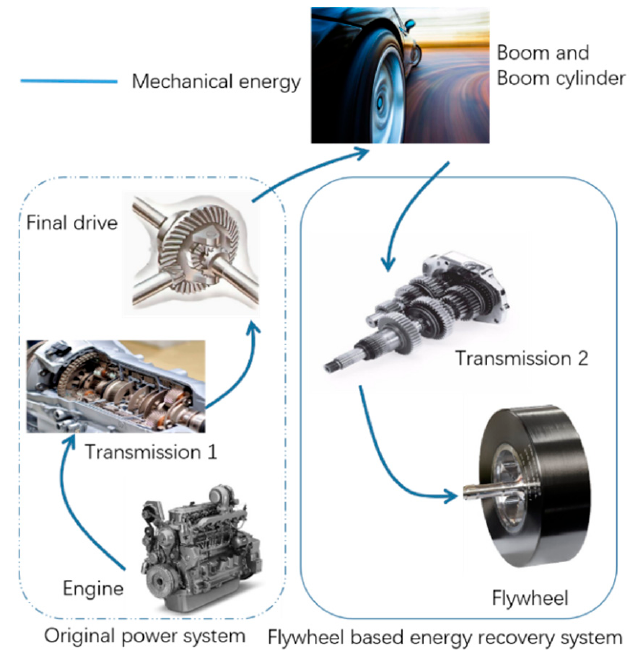
Figure 3. Automobile application schematic of the flywheel-based energy recovery system.